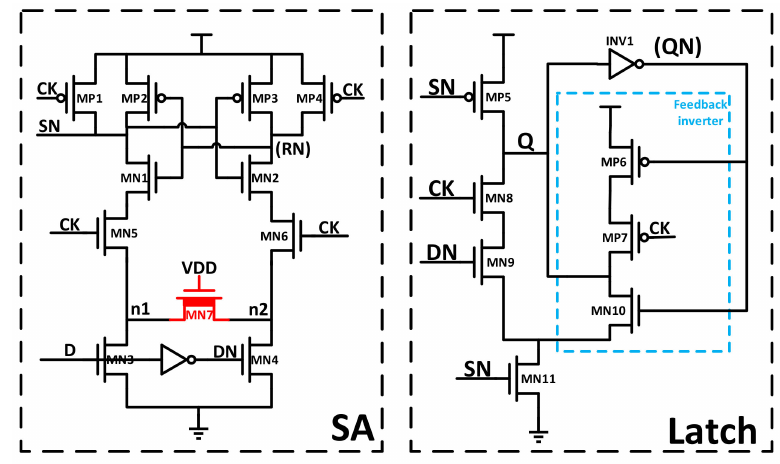
Figure 5. Schematic of the proposed